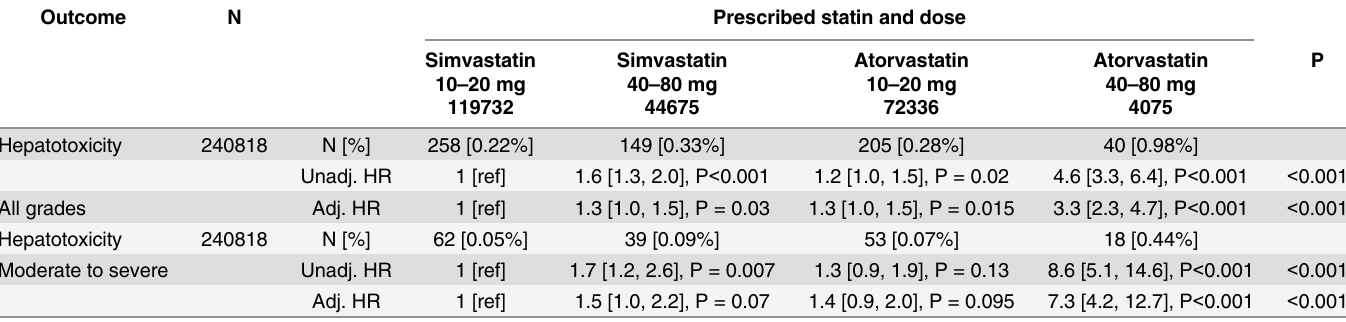
Table 5. Hazard ratio [HR] estimates [95% CI] for significant lab events associated with prescribed statin and dose during the first 6 months ther- apy on treatment, relative to low dose